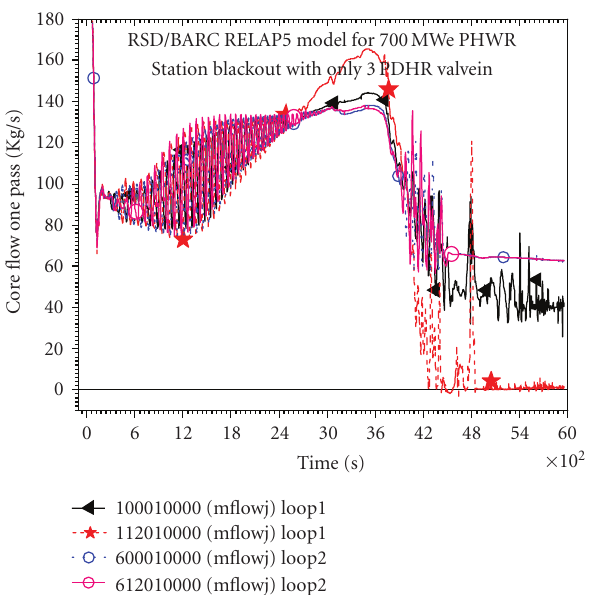
Figure 20: Core flow case-3PDHRs with loop isolation.